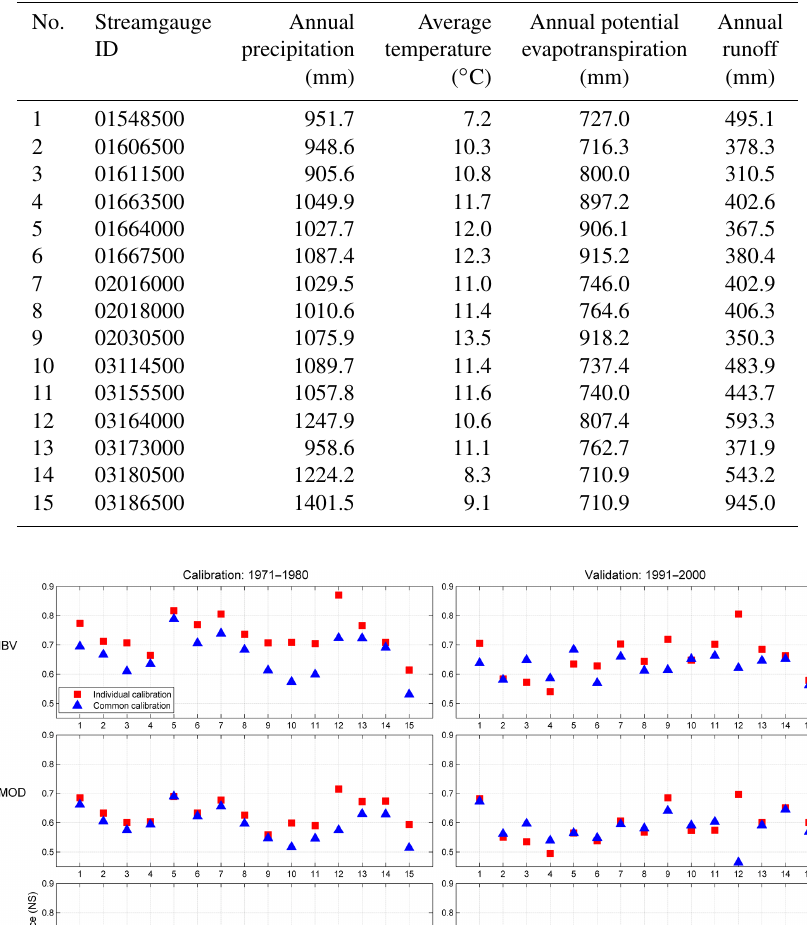
Table 2. Climate variables of the 15 selected catchments.